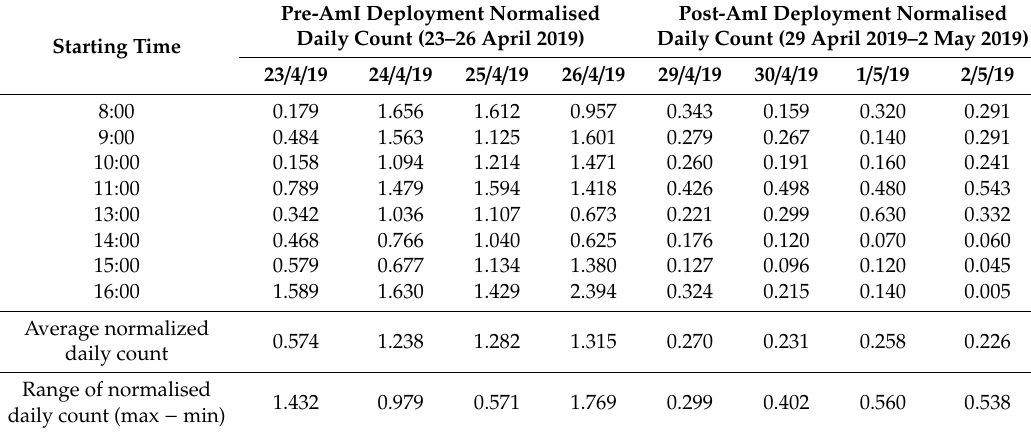
Table 3. Normalised data from the pre- and post-AmI deployment